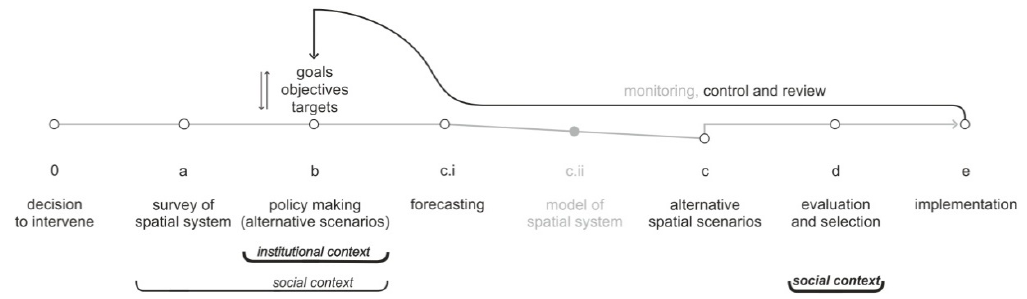
Figure 3. The elements of rational land-use planning, according to Faludi [6,10,11], in diagrammatic form, with the comprehensive model’s components in the background. White circle: coincidence with McLoughlin’s component. Gray circle: lack of the corresponding McLoughlin component. Below the axis: contextual factors.